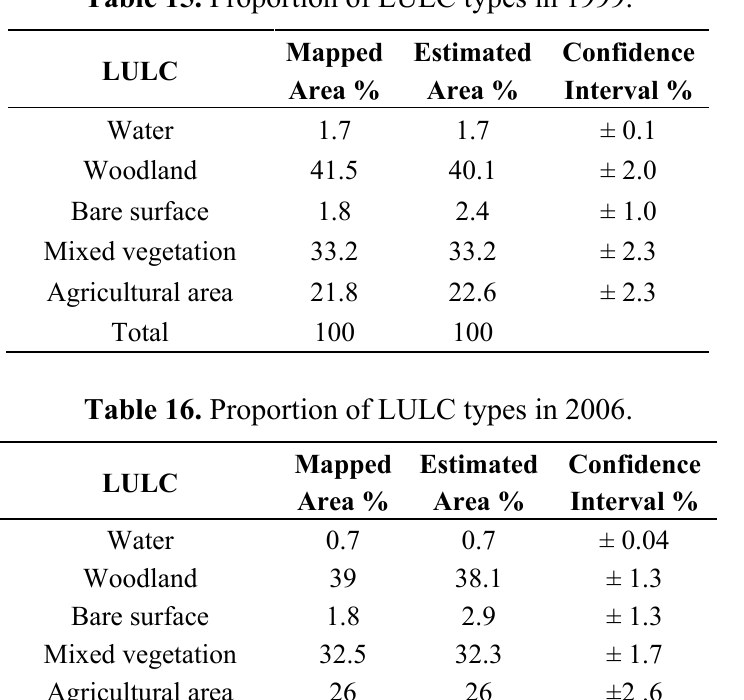
Table 15. Proportion of LULC types in 1999.